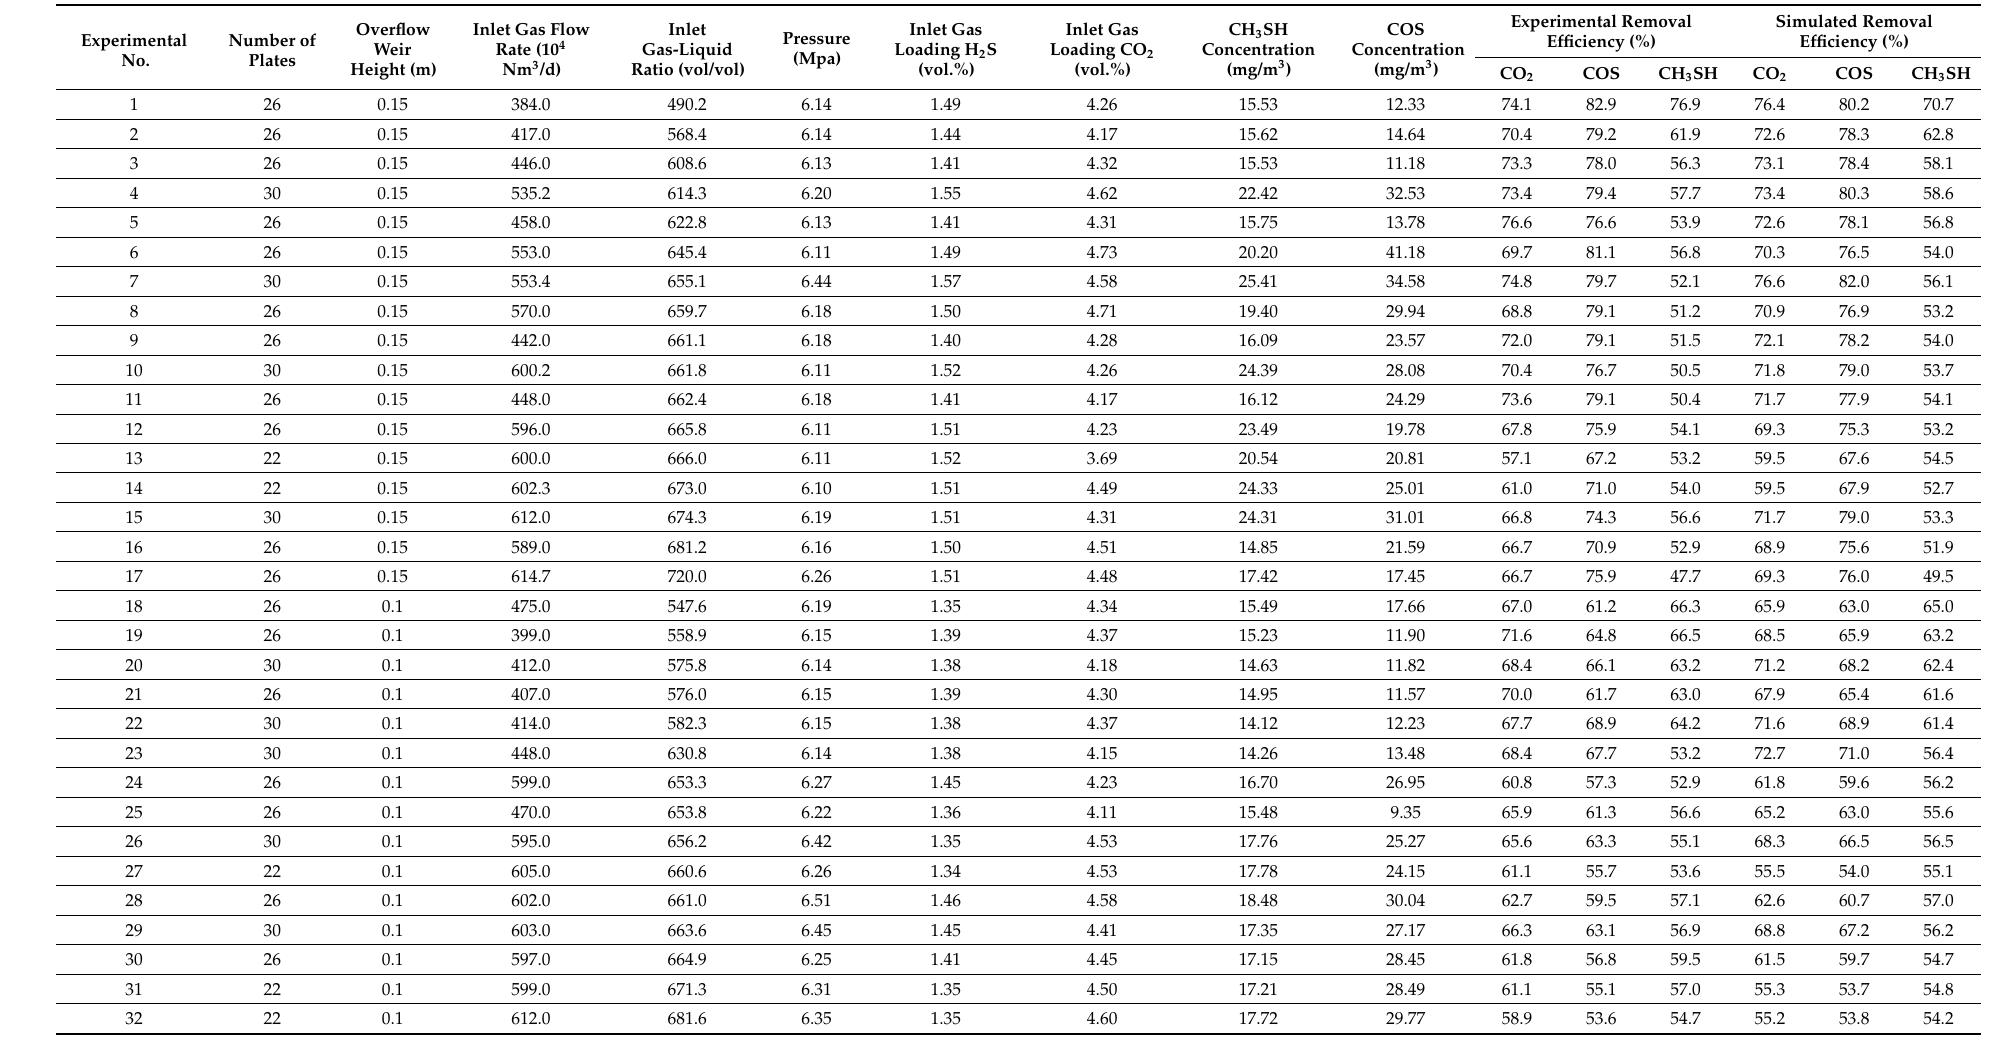
Table 3. Comparison of experiment data and model calculation data from the